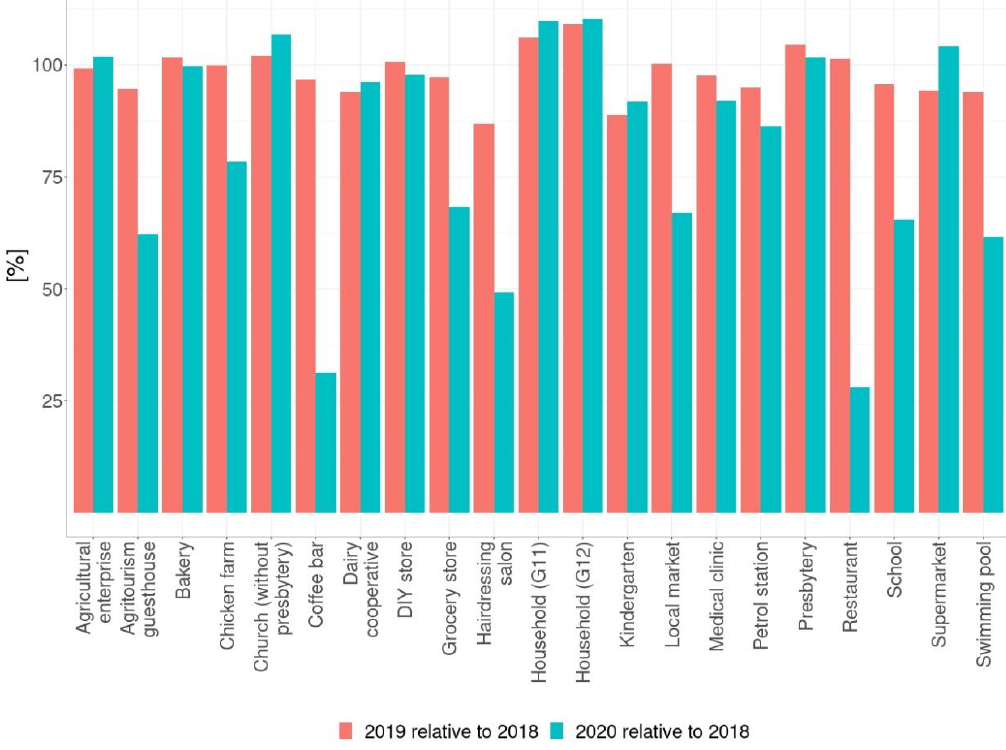
Figure 7. Change in electricity consumption from the network storage. ● In Poland, the distribution and transmission network operators diagnosed a nega- tive impact of prosumers using photovoltaic sources on the network’s operation. The consequence of this diagnosis is the emergence of mechanisms alternative to the current prosumer support model and aimed at marketizing the functioning model. On the one hand, there is therefore mention of the high operating costs of the existing support model, which are cross-subsidized and transferred to consum- ers who are not prosumers, and, on the other hand, it is declared that the new mod- el is to be more beneficial to prosumers. Is a win-win model possible? Figure 8 shows the energy purchase cost for each scenario averaged for the period from March 2018 to March 2021, and for all prosumers analyzed representing various industries in relation to the averaged energy purchase cost by consumers before they became prosumers. The most beneficial effect is the case_0 scenario, reflecting the currently applicable discount model. In this scenario, the average prosumer re- duces the electricity purchase cost by 95.5% (only 4.5% of the original cost is left). The least beneficial scenarios include migration to the 1:1 discount model, where the prosumer incurs the full distribution cost for the energy taken (case_2) and the scenario of reselling surplus energy at the CRK and purchase of energy at tariff prices (case_1). For these variants, the average prosumer reduces the electricity purchase cost by 81.5%, still incurring about 18.5% of the original level of energy purchase costs. Nor does the resale of energy at market prices improve the eco- nomic performance observed by the prosumer either in the case_3 or case_4 sce- narios.